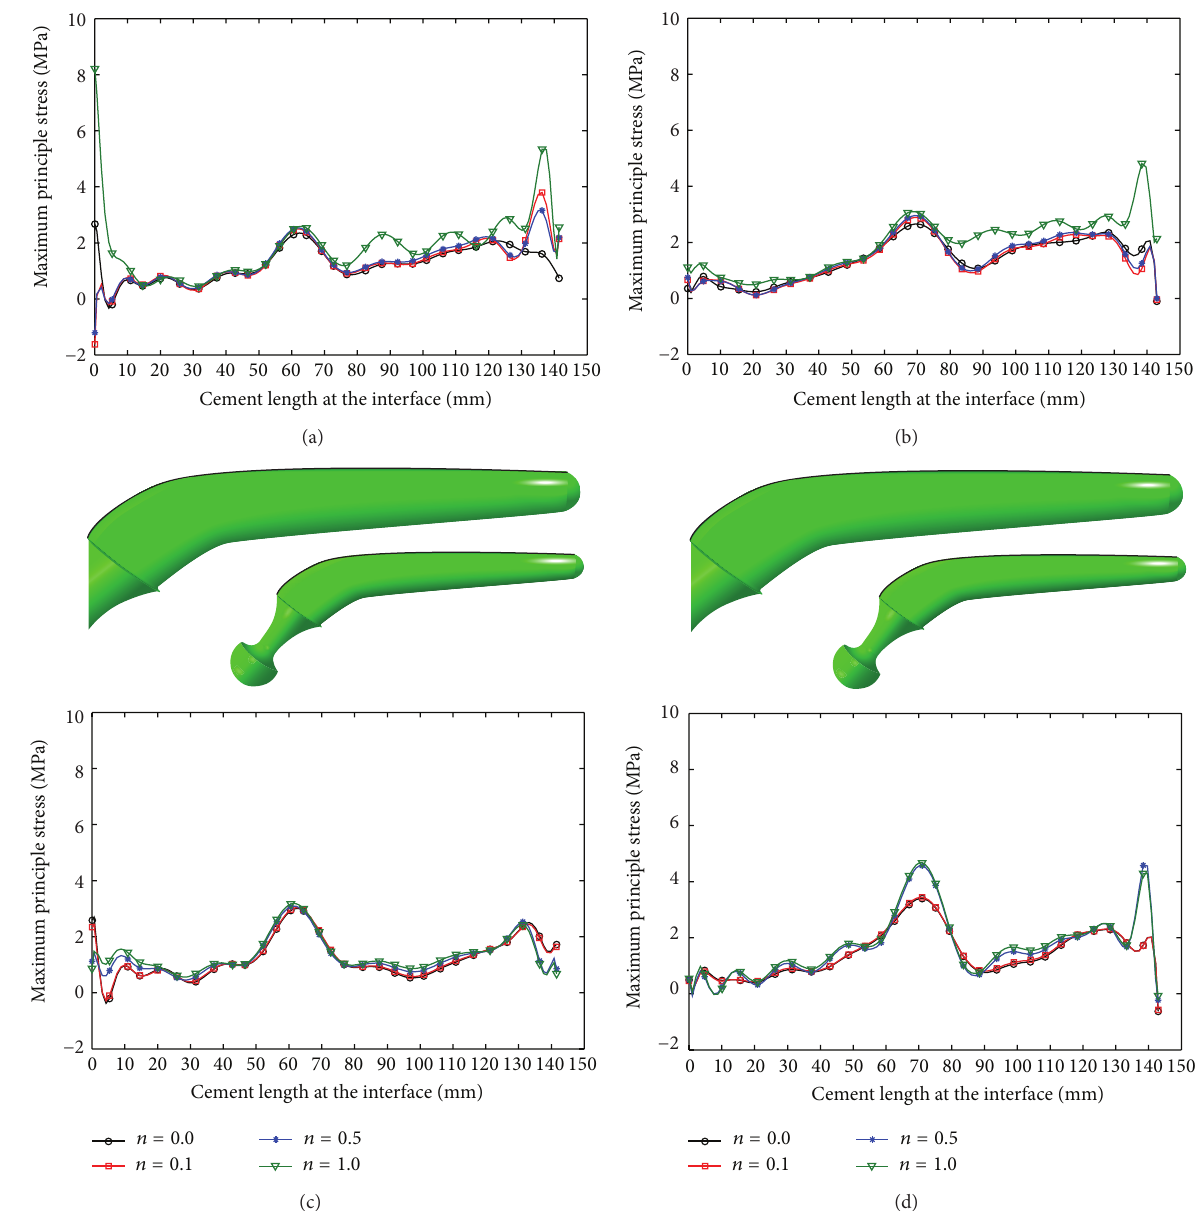
Figure 11: Maximum principal stress variation on the cement surface due to longitudinal prosthesis: (a) normal walking, internal surface, (b) normal walking, external surface, (c) stair climbing, internal surface, and (d) stair climbing, external surface.